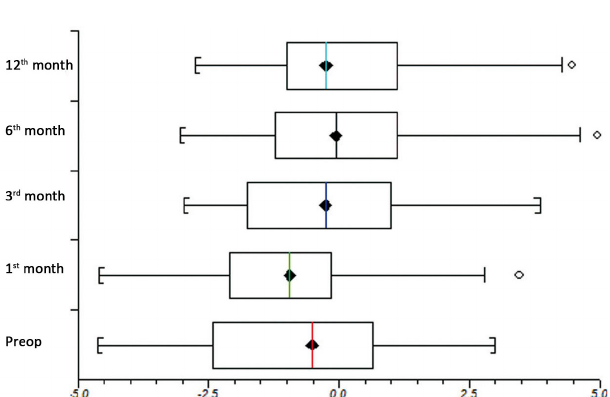
Fig. 5 - Evolution of z-scores for brachial perimeter/age (BPAZ) in the group of cardiac patients. Analysis of variance with P=0.266. There was no difference compared with the general population